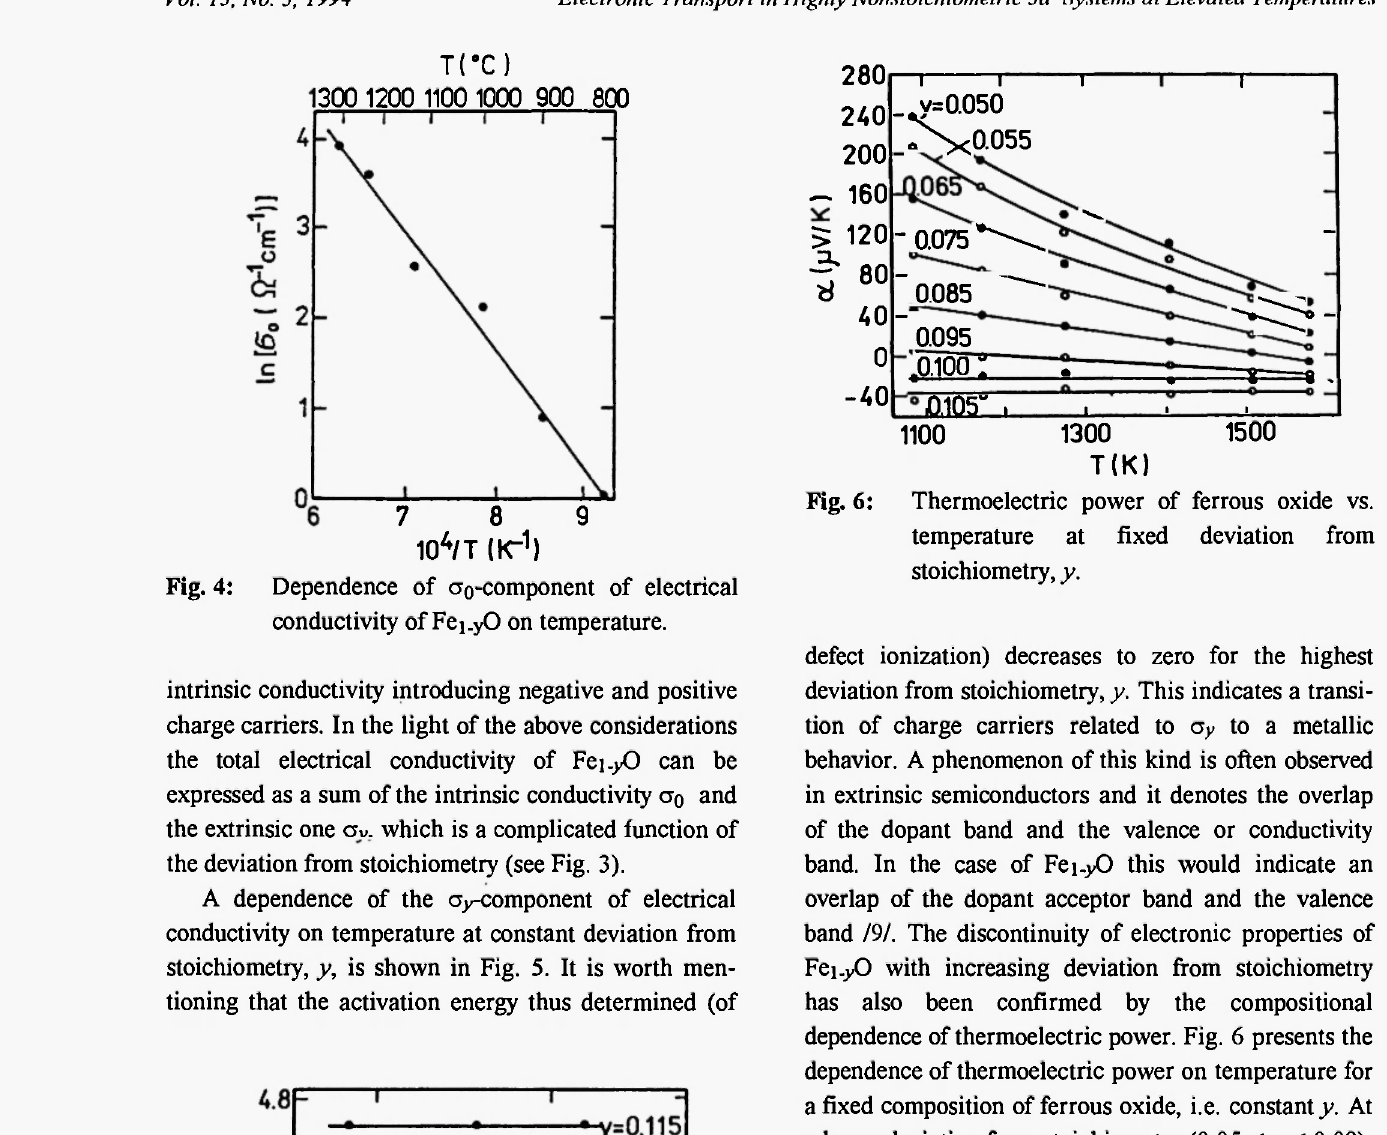
Fig. 6: Thermoelectric power of ferrous oxide vs. temperature at fixed deviation from stoichiometry, y. Fig. 4: Dependence of σο-component of electrical conductivity of Fei.yO on temperature. defect ionization) decreases to zero for the highest deviation from stoichiometry, y. This indicates a transi- tion of charge carriers related to ay to a metallic behavior. A phenomenon of this kind is often observed in extrinsic semiconductors and it denotes the overlap of the dopant band and the valence or conductivity band. In the case of Fei-yO this would indicate an overlap of the dopant acceptor band and the valence band 191. The discontinuity of electronic properties of Fei.yO with increasing deviation from stoichiometiy has also been confirmed by the compositional dependence of thermoelectric power. Fig. 6 presents the dependence of thermoelectric power on temperature for a fixed composition of ferrous oxide, i.e. constant y. At a lower deviation from stoichiometry (0.05 <y < 0.08), the behavior of ferrous oxide is typical of semi- conductors, the significant decrease of thermoelectric power with increasing temperature is associated with increasing negative input to the thermoelectric power brought about by intrinsic electrons σο. At higher deviations from stoichiometry, y > 0.9, the thermo- electric power assumes small negative values and is practically independent of temperature. Such a behavior cannot be explained in terms of a classical band model. Fig. 7 shows schematically the proposed model of the electronic structure of ferrous oxide. From the Fig. 5: ay-component of electrical conductivity of viewpoint of electronic structure, the deviation from ferrous oxide vs. temperature at fixed stoichiometry introduces two acceptor levels into deviation from stoichiometry. ferrous oxide, Fe 3+ octahedral and Fe 3+